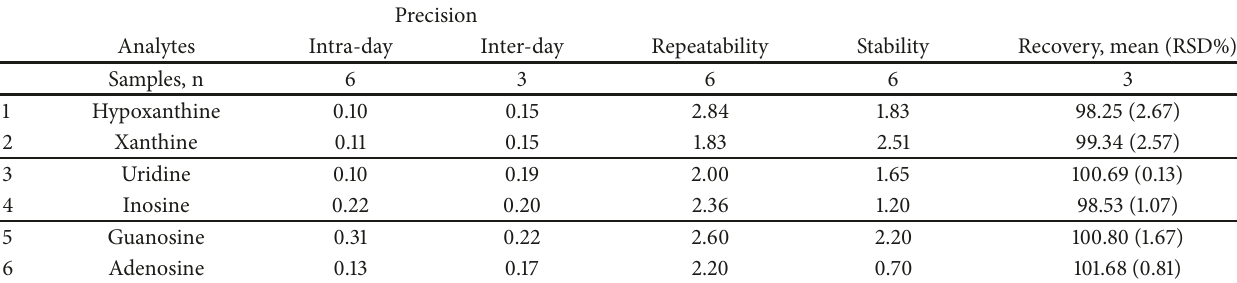
Table 3: Precision, repeatability, stability, and recovery of six nucleosides of commercial Guang Dilong ∗ .